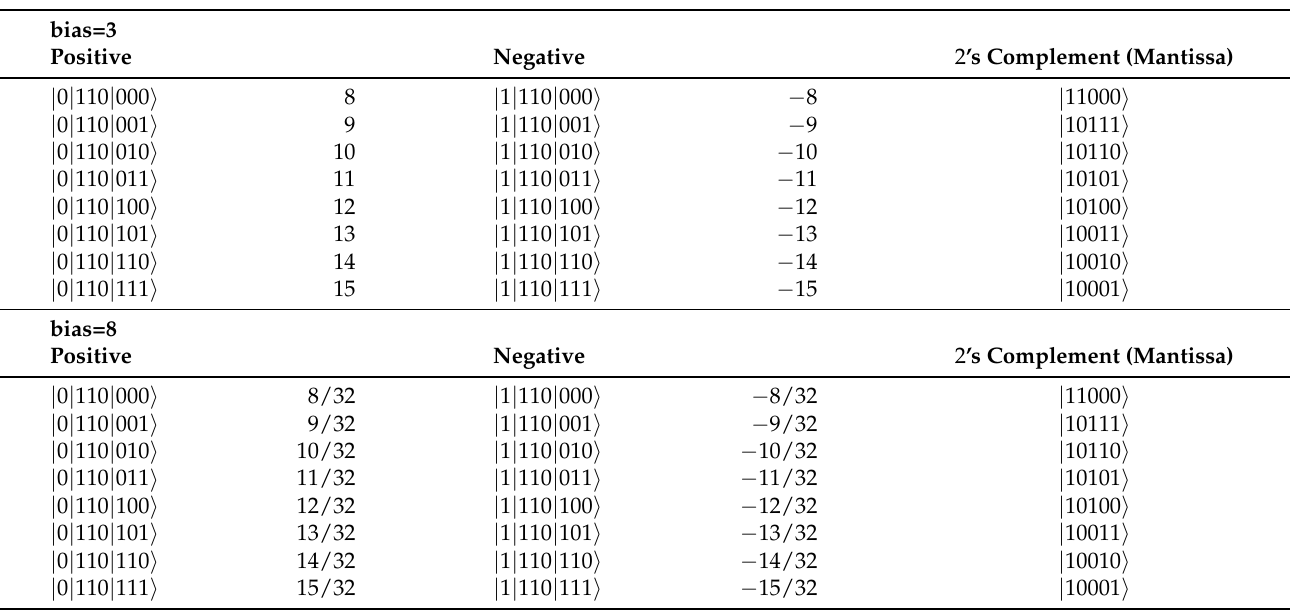
Table A2. Example of normalized floating-point numbers with four mantissa and three exponent qubits. Exponent has value of six (110 in binary). The sign is defined by the leading